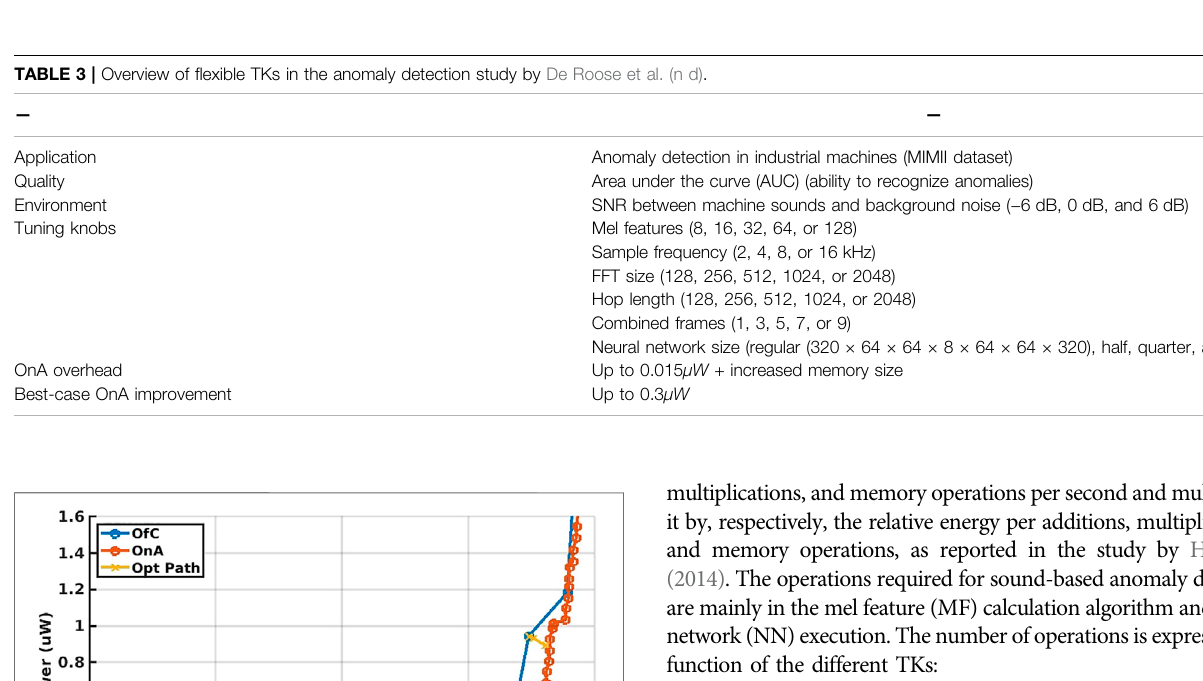
FIGURE 12 | Main architecture of the work of De Roose et al. (n d).